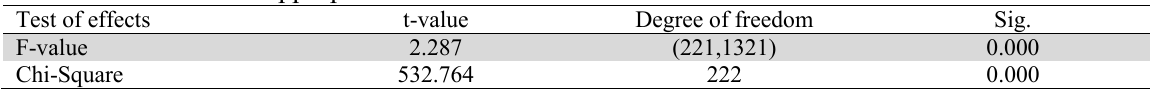
Chow test to select the appropriate model Test of effects